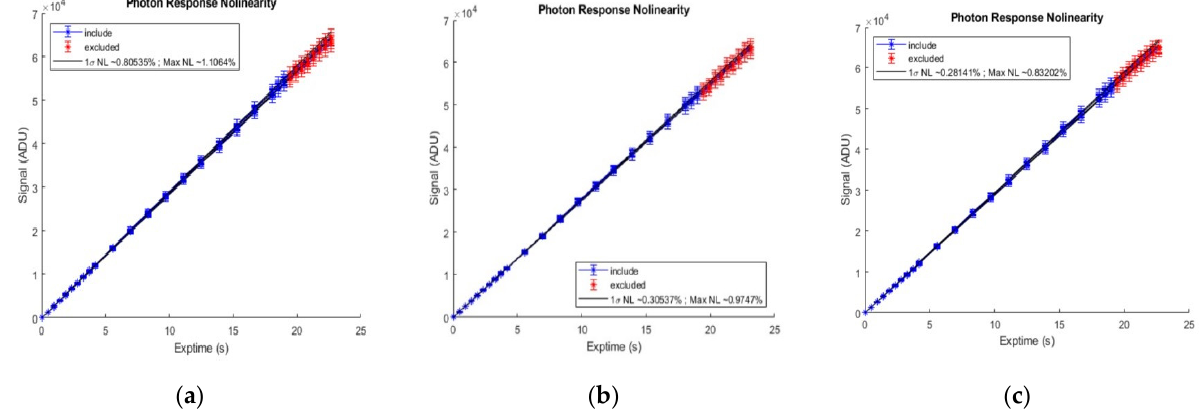
Figure 17. The nonlinearity test result of camera. ( a ) 28 June 2022 test result; ( b ) 6 July 2022 test result; ( c ) 19 July 2022 test result.